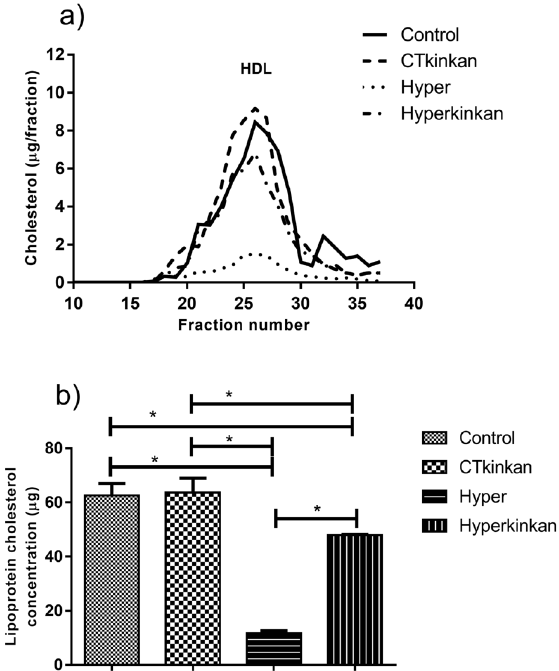
Figure 1. Cholesterol distribution on circulating lipoproteins in rats given Control, CTkinkan, Hyper and Hyperkinkan diets, after 4 weeks of experiment. a) Cholesterol profile found in lipoprotein fractions analyzed. b) Mean values of the sum of the cholesterol concentration found in the different experimental groups. Gel filtration chromatography was performed using a Superose 6 column (Pharmacia) on a Waters 600 FPLC system. The pooled serum (a 100µl aliquot) was loaded onto a Superose 6 column and separated as described above. Cholesterol determinations were measured in the microplate assay. Data points represent mean values for cholesterol from three pooled serum from each group (n=5). *Bars in Figure 1b represent statistical significance, p < 0.05, using two- way ANOVA followed by post hoc Bonferroni